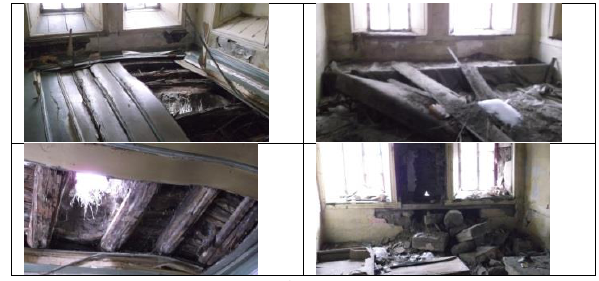
Figure 5. Structural Status of the house during scanning